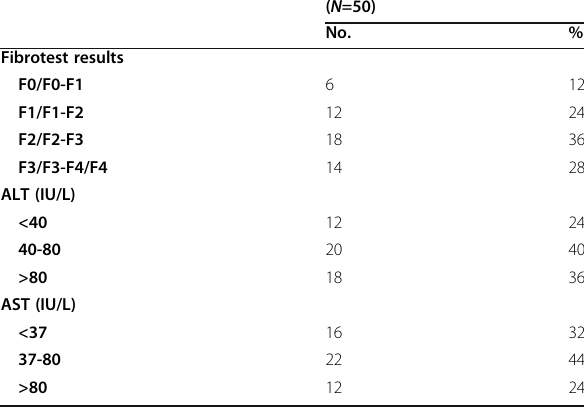
Table 2 Results of Fibrotest and liver